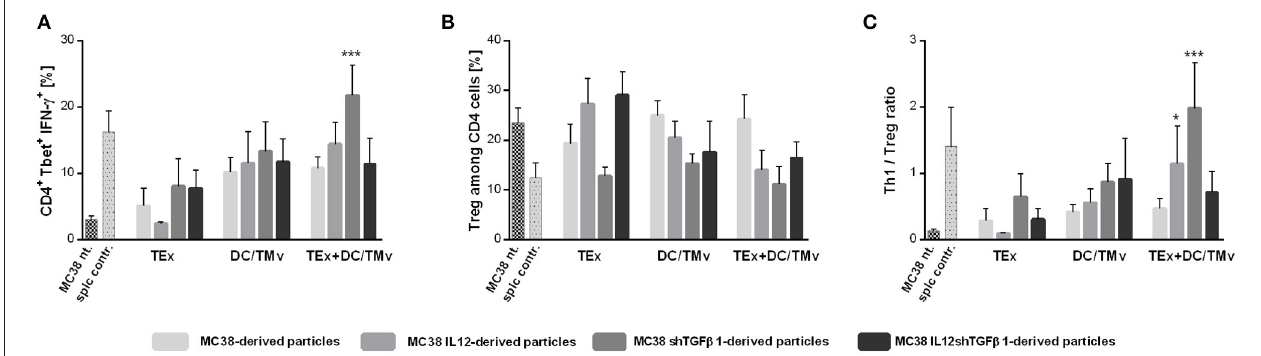
FIGURE 6 | Polarization of immune response following mTEx and DC/mTMv treatment. (A) Bar plots presenting changes in Tbet expression and IFN- γ production in CD4 + cells from spleens of treated mice. (B) The percentage of Treg cells among CD4 + cells from spleens of treated mice. (C) The Th1/Treg ratio. To calculate the mean ± SD, 6–8 mice per group were analyzed. The differences between the groups were estimated using the nonparametric Kruskal-Wallis test followed by Dunn’s multiple comparison test (* p < 0.05, *** p < 0.001 in reference to MC38